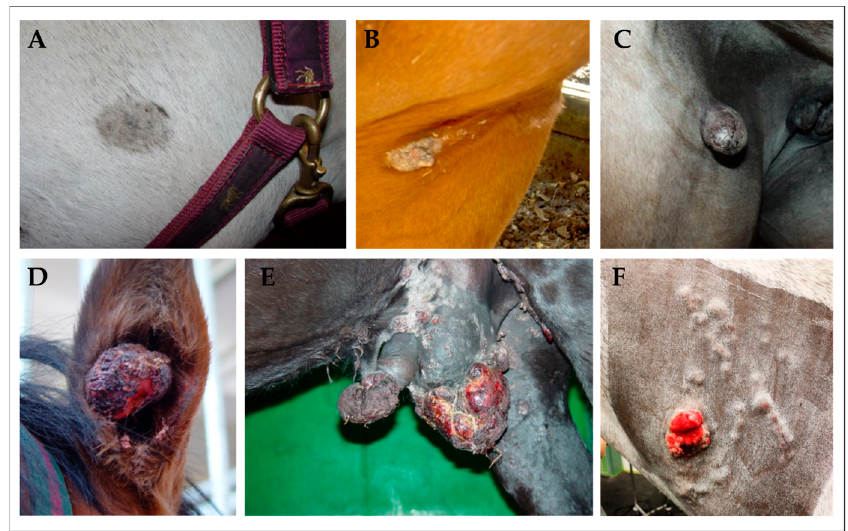
Figure 1. Clinical classification of sarcoids in equids. ( A ): mild-type occult sarcoid presenting as discrete, round-to-oval hairless area on the left jaw of a Warmblood gelding; ( B ): verrucous sarcoid—an irregular, hyperkeratotic area with marked skin-thickening in the axillary region of a Quarter horse; ( C ): nodular sarcoid—a firm dermal nodule covered by apparently intact epidermis in the inguinal region of a Warmblood mare; ( D ): fibroblastic sarcoid affecting the right ear of a Warmblood gelding. The tumor presents as aggressive, ulcerated lesion exhibiting epidermal erosion; ( E ): mixed sarcoid affecting the genital region of a Noriker horse gelding. This tumor conglomerate comprises verrucous, nodular, and fibroblastic lesions; ( F ): malevolent sarcoid on the left neck of an equine patient. This rare, but most aggressive sarcoid-type typically spreads along lymphatic vessels under apparently intact skin, and usually comprises fibroblastic lesions [23] .